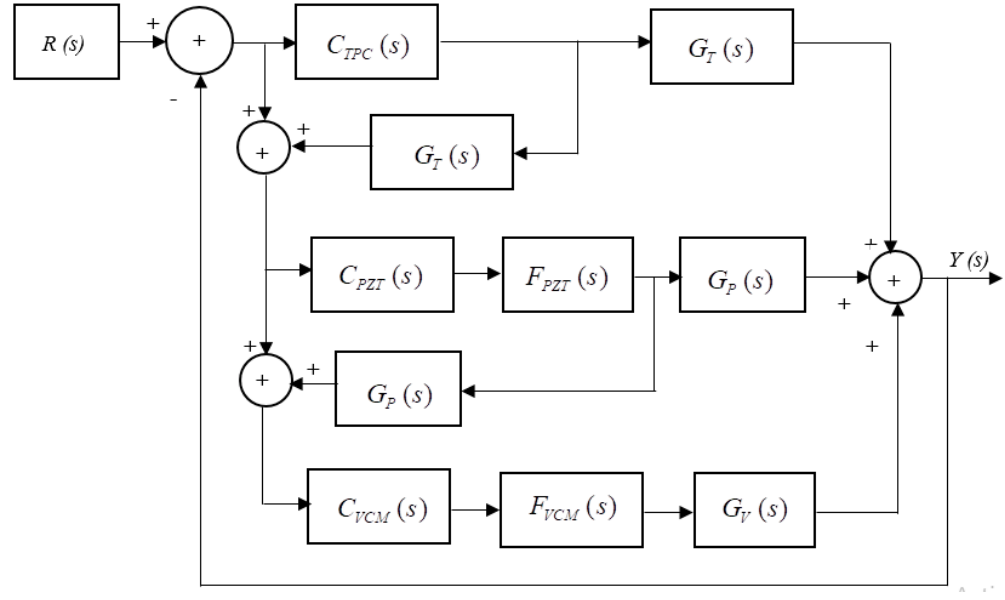
Figure 9. Decoupled master–slave control architecture for triple-stage hard disk drive (HDD).